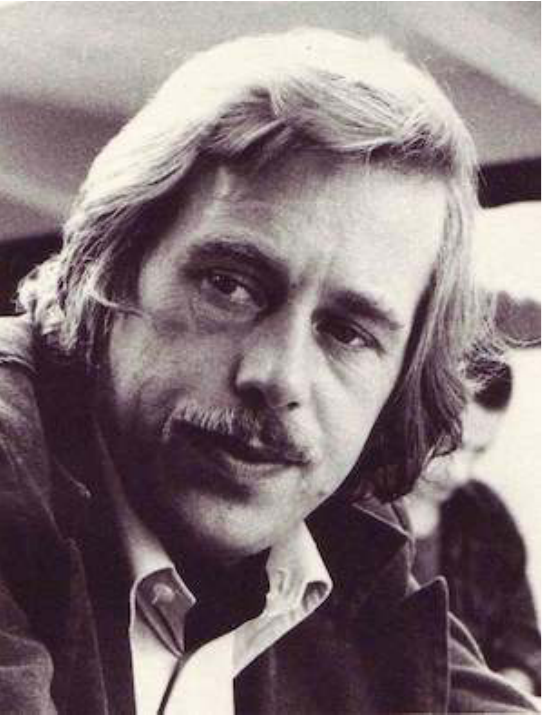
Figure 4. Portrait of Václav